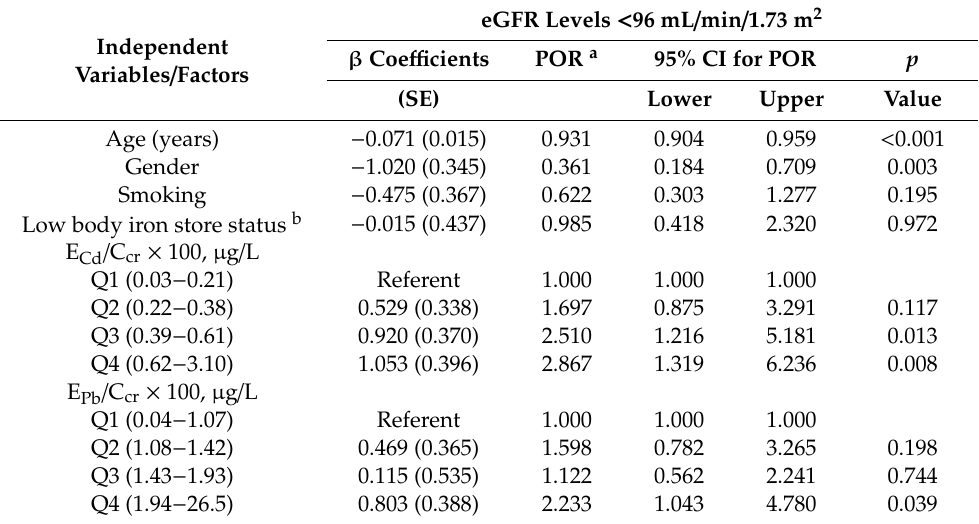
Table 3. Prevalence odds ratios for the reduced eGFR across the E Cd / C cr and E Pb / C cr